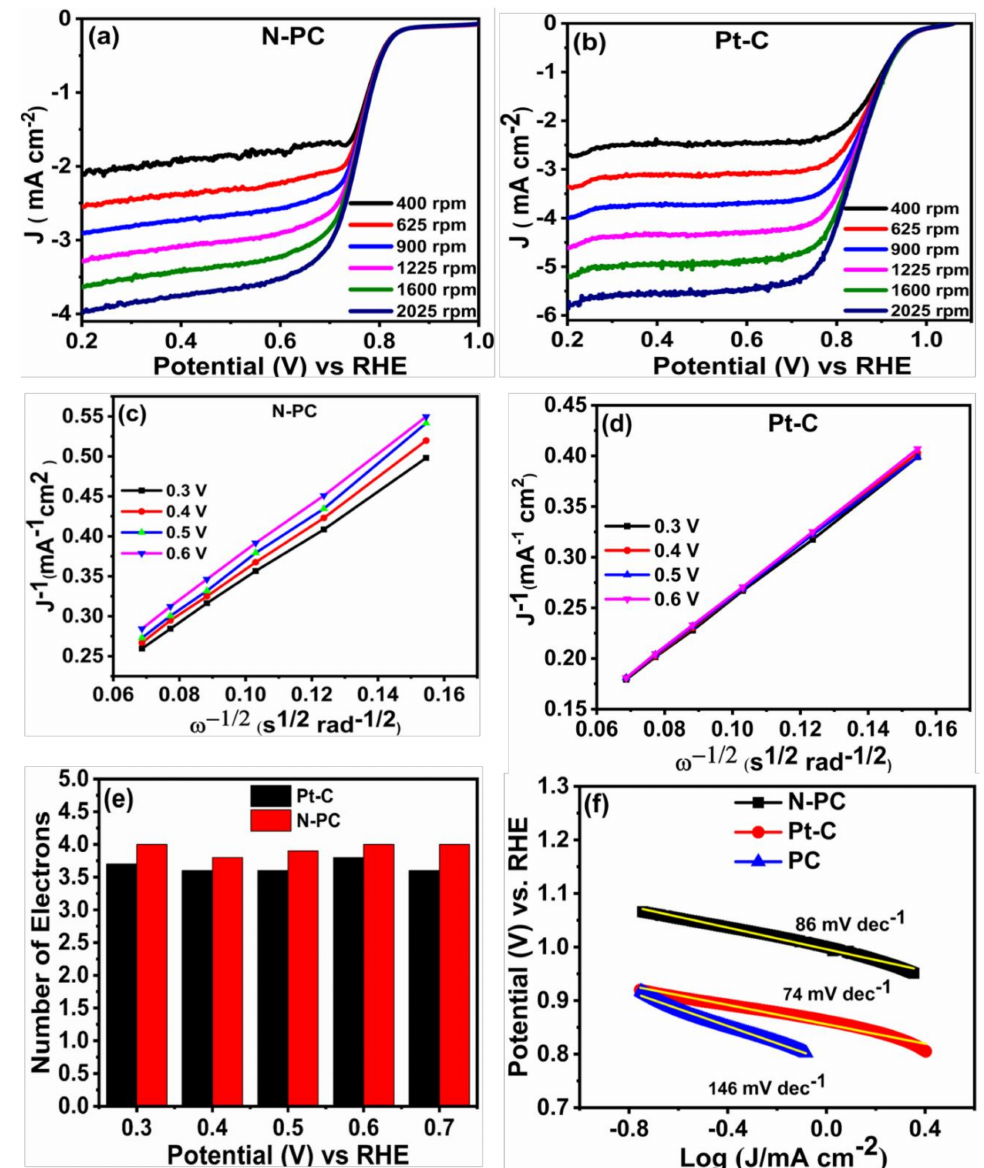
Figure 7. LSV curves of ( a ) N-PC and ( b ) Pt-C obtained from RRDE measurement with di ff erent rotation speeds in O 2 saturated 0.1 M KOH at a scan rate of 10 mV s − 1 ; Koutecky–Levich plots of ( c ) N-PC ( d ) Pt-C; ( e ) plot of potential vs number of electrons and ( f ) Tafel slopes of PC, N-PC and